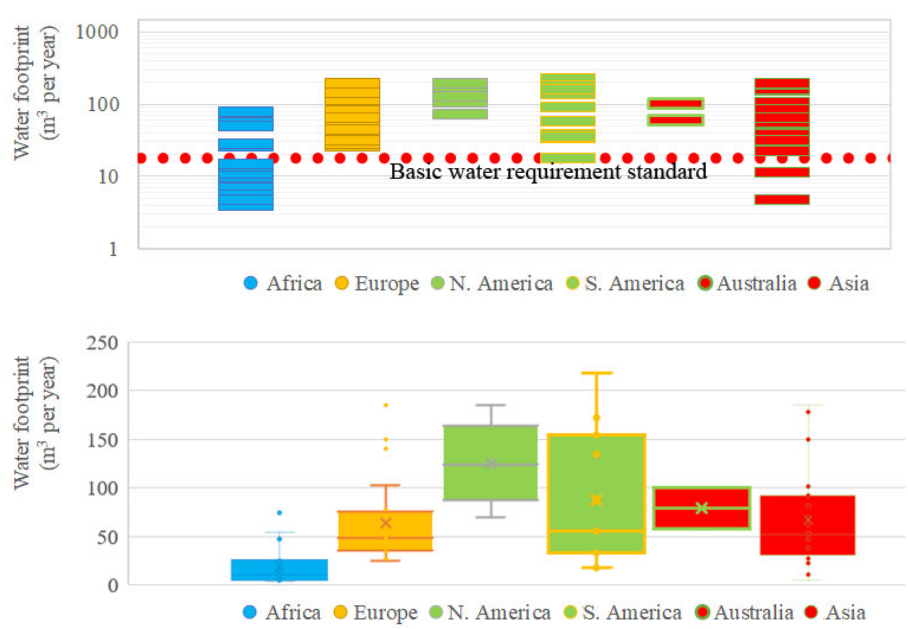
Figure 12. Annual water footprint (consumption of domestic blue water) per capita in different countries (2005) (data from [168,169]). Top: plot in logarithmic scale indicating the basic water requirement standard; bottom: box plot.